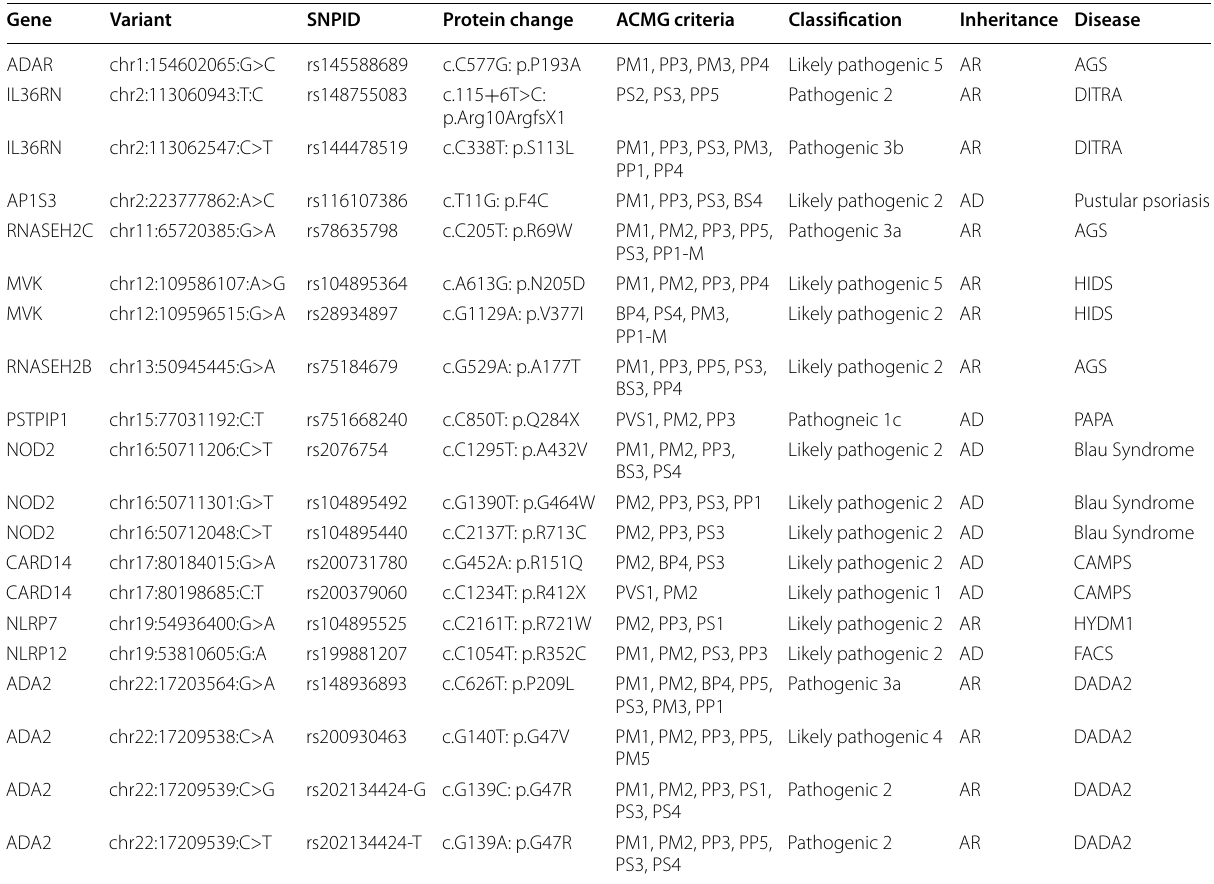
Table 2 Pathogenic and likely pathogenic variants classified by ACMG-AMP guidelines